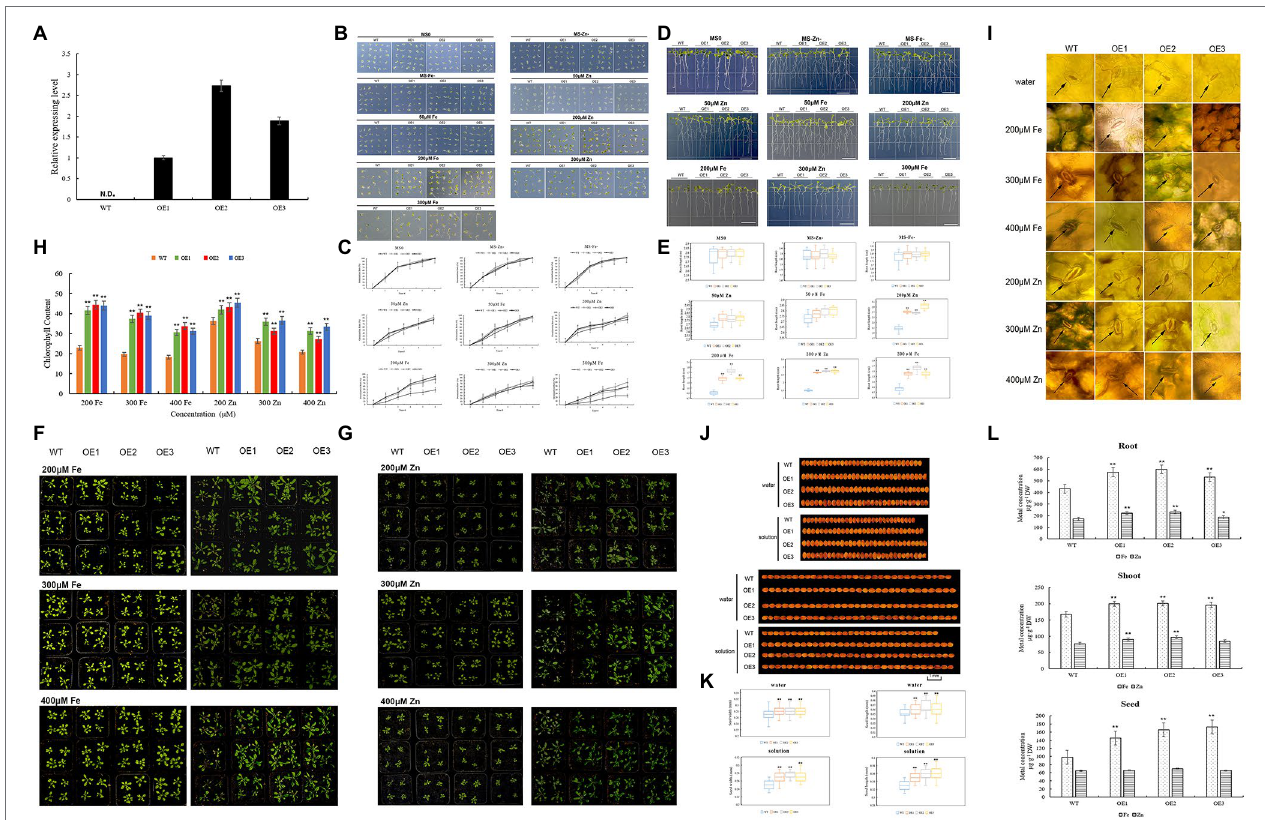
FIGURE 8 | Comparison of the phenotypic performance of three TaZIP13-B overexpression Arabidopsis lines and wild type. (A) The expression level of TaZIP13-B in T3 transgenic Arabidopsis lines. Bars indicate standard deviations of three biological replicates; (B,C) seed germination rate with different treatment; (D,E) root length of WT and three transgenic lines (bar = 1 cm); (F,G) phenotypic identification of Arabidopsis treated with ZnSO 4 and FeCl 3 solution, respectively (concentration: 200, 300, 400 μ mol/L); (H) chlorophyll content; (I) phenotype of stomata; (J,K) seed width and length (bar = 1 mm, n > 30); (L) the content of Zn and Fe in roots, shoots and seeds. Statistically significant differences are indicated: * p < 0.05; ** p < 0.01 (Student’s t